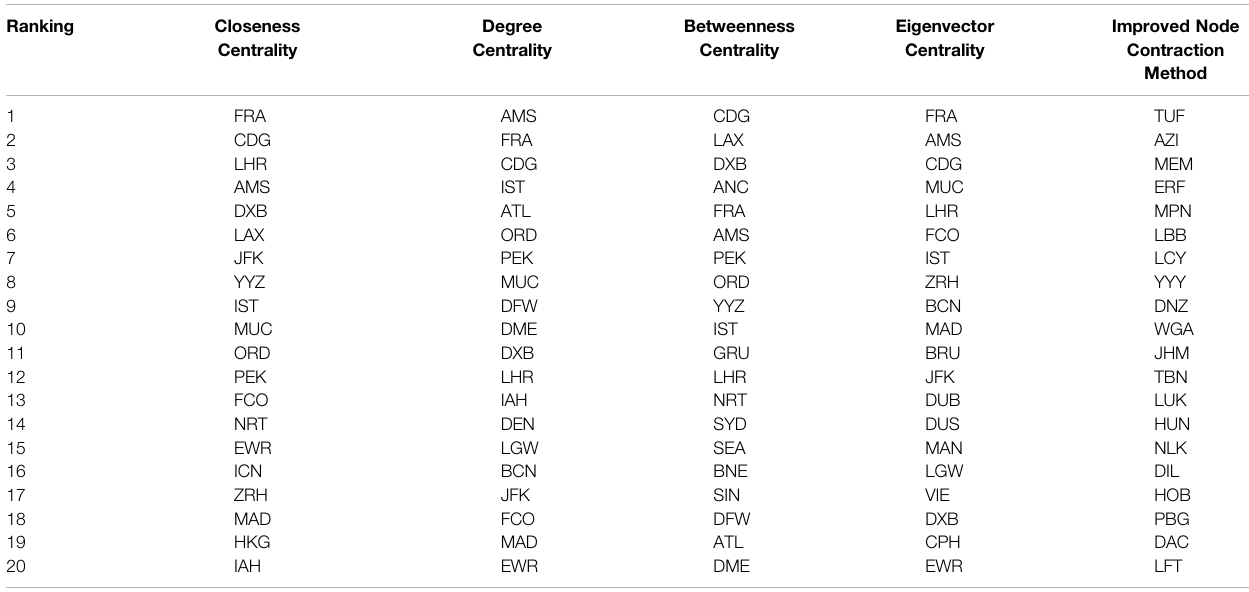
Degree Centrality